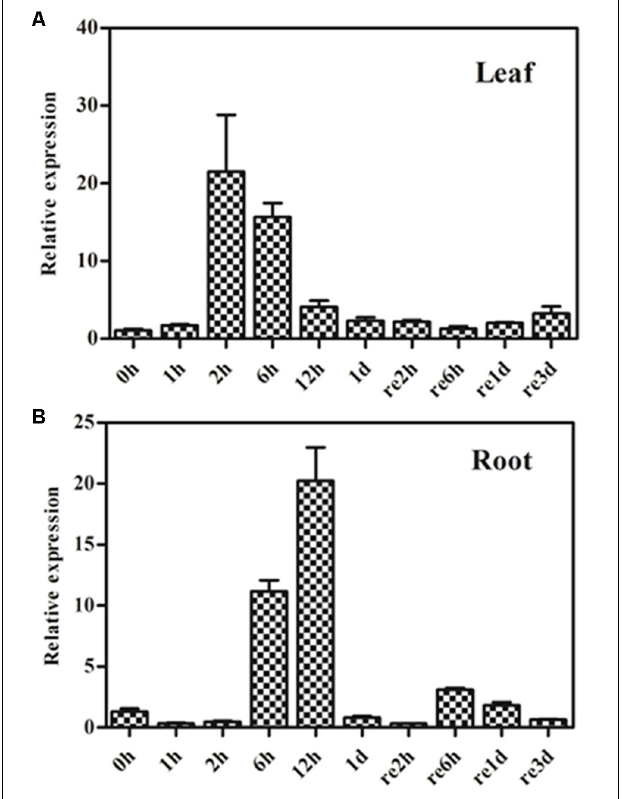
FIGURE 4 | Expression pattern of GmPIP2;9 in soybean plants under normal and drought treatments. Thirteen-day-old soybean seedlings were treated with or without 20% polyethylene glycol (PEG) in nutrient solution. Total RNA was extracted from (A) leaves and (B) roots of these seedlings at 1 h, 2 h, 6 h, 12 h, and 1 day (1–12h and 1d) of PEG treatment, and 2 h, 6 h, 1 day, and 3 days of the recovery (re2h, re6h, re1d, and re3d). Data represent the means ± SD . Three replicates were used. Expression levels of treated plants are relative to control plants at each time